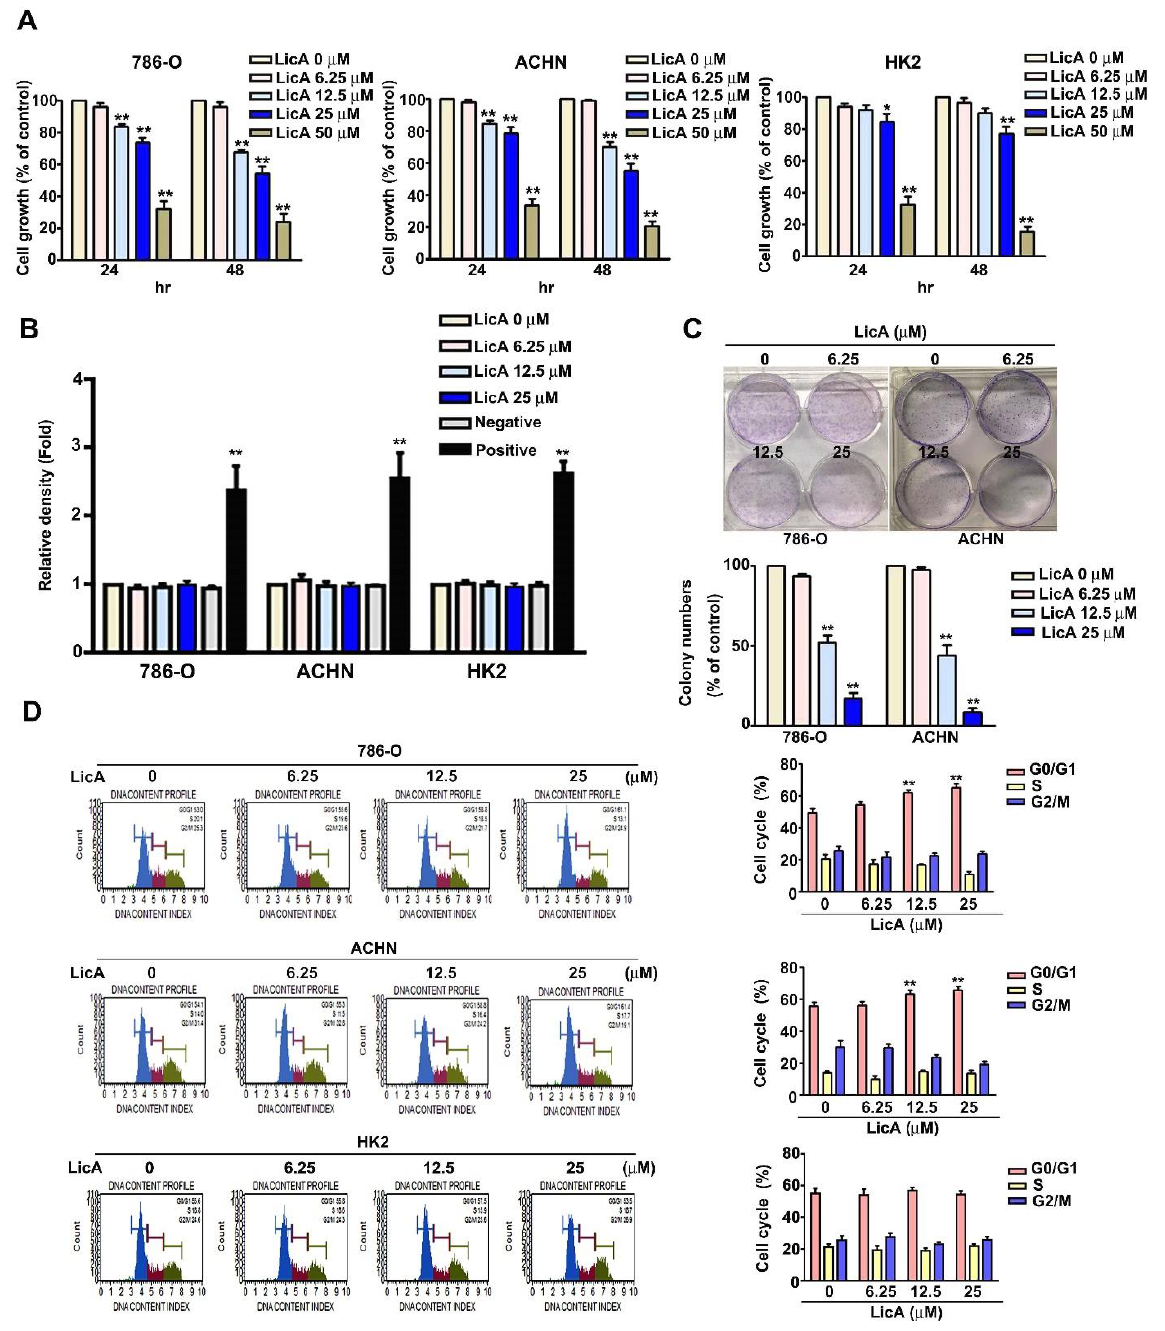
Figure 1. The effects of LicA on RCC cell proliferation. ( A ) For 24 and 48 h, different doses of LicA (0, 6.25, 12.5, 25, and 50 µM) were incubated with RCC (786-O, ACHN) and normal renal tubular (HK2) cells. Cell proliferation was evaluated using MTT assay. ( B ) LDH assay and spectrophotometry were used to test for cell toxicity in RCC cells (786-O and ACHN) and normal HK2 cells after exposure to different doses of LicA (0, 6.25, 12.5, and 25 µM) for 24 h (positive control with 1% Triton X100). ( C ) The proliferation of 786-O and ACHN cells was then determined by harvesting the cells with different LicA concentrations (0, 6.25, 12.5 and 25 µM) and counting the number of colonies. ( D ) PI staining and flow cytometry were used to investigate the cell cycle distribution of RCC cells (786-O, ACHN) and normal HK2 cells that had been exposed to different doses of LicA (0, 6.25, 12.5, and 25 µM). The results are shown as the mean ± SD of at least three different tests. * p < 0.05; ** p < 0.01, compared with that of the untreated control (0 µM).